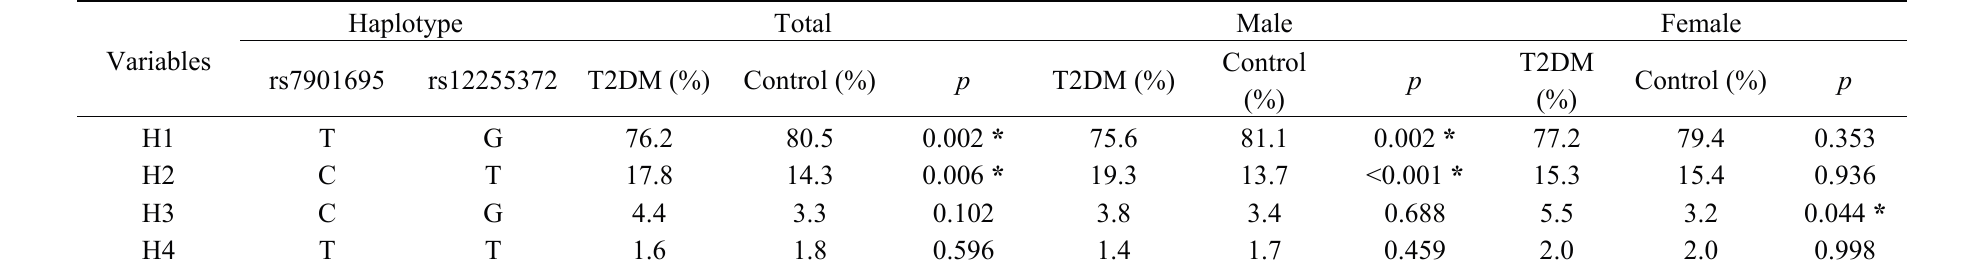
Table 6. Haplotype analysis in patients with T2DM and control